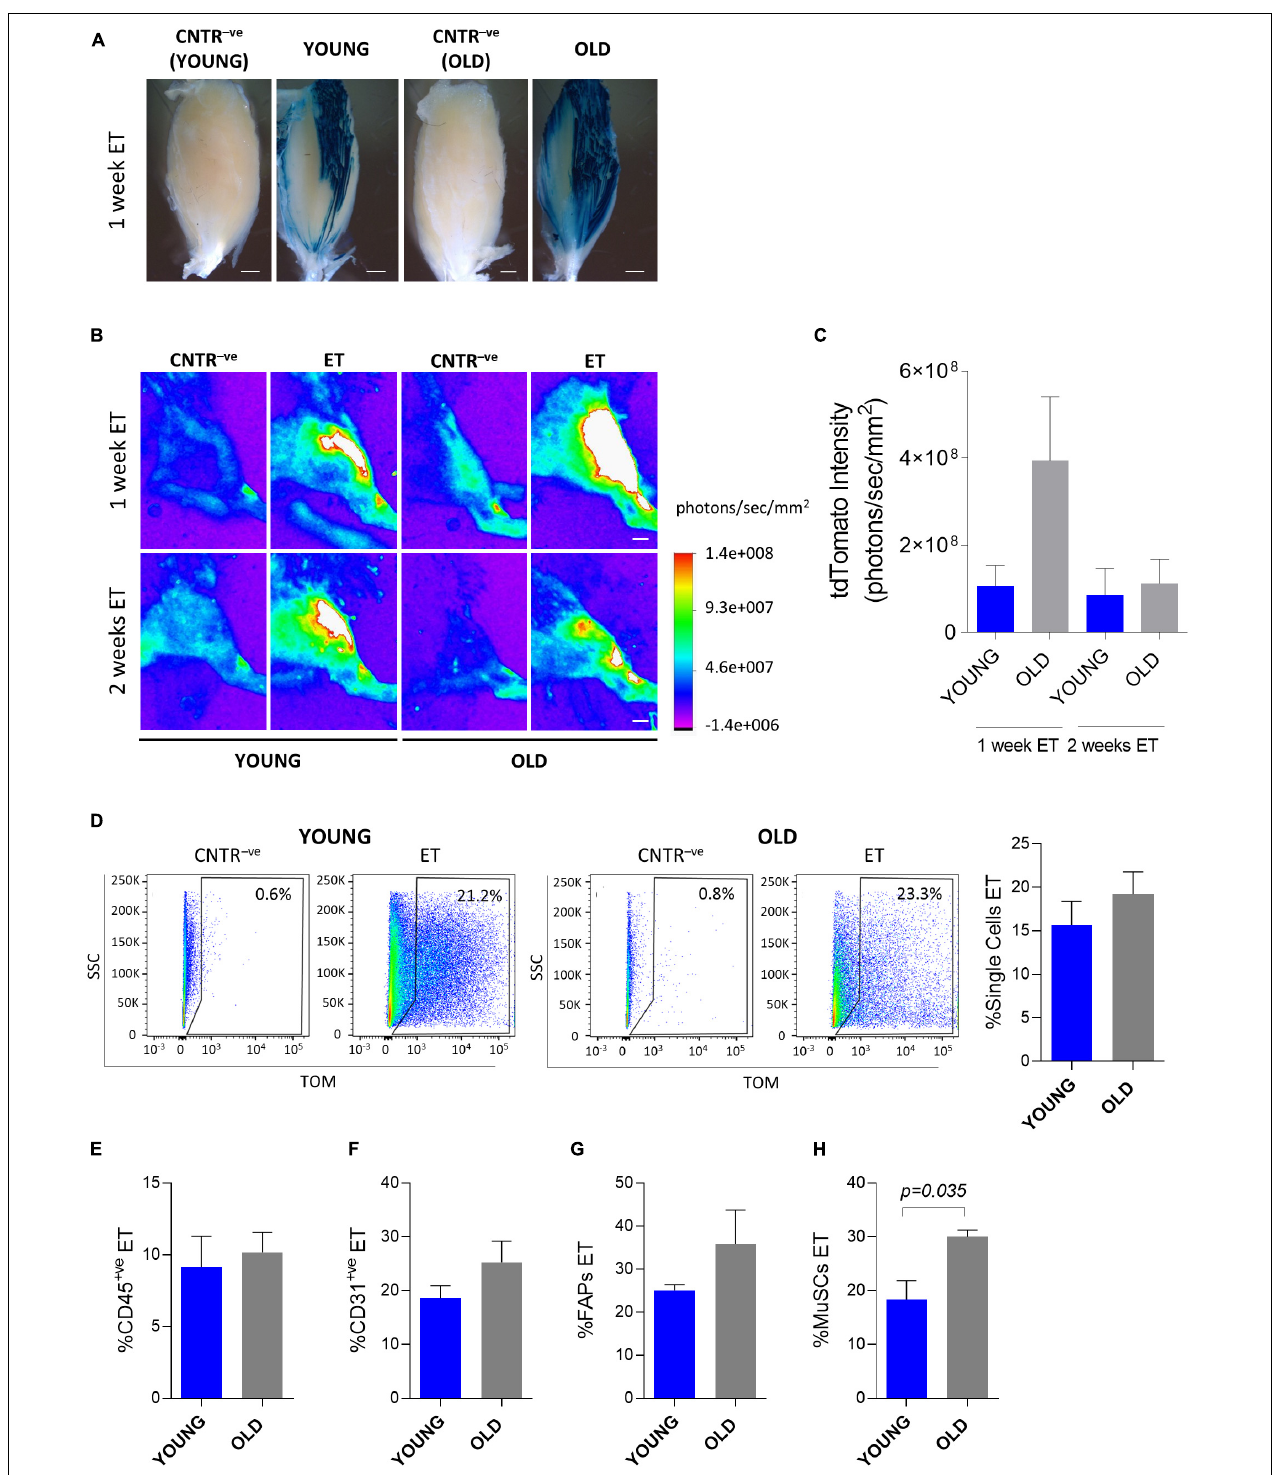
FIGURE 5 | In vivo electroporation of old muscles. (A) Whole-mount X-gal staining of TA from ∼ 2 months-old C57BL/6J (YOUNG), and ∼ 24 months-old C57BL/6J (OLD) mice. PBS (CNTR – ve ) or β -gal plasmid (YOUNG, OLD) were injected in muscles prior electroporation. Muscles were collected 1 week after electroporation. Scale bar: 0.85 mm. (B) Representative Bruker In Vivo Xtreme I images of tdTomato intensity (photons/sec/mm 2 ) of TA from muscles of ∼ 2 months-old (YOUNG) and ∼ 24 months-old (OLD) C57BL/6J mice injected with PBS (CNTR – ve ) or with tdTomato plasmid (ET) and electroporated. Scale bar: 2.5 mm. White color in the figure indicates photons/sec/mm 2 > 1.4e+008. The analysis was performed 1 and 2 weeks after electroporation. (C) tdTomato intensity measurement (photons/sec/mm 2 ) of TA of ∼ 2 months-old (YOUNG) and ∼ 24 months-old (OLD) C57BL/6J mice injected with tdTomato plasmid and electroporated. The